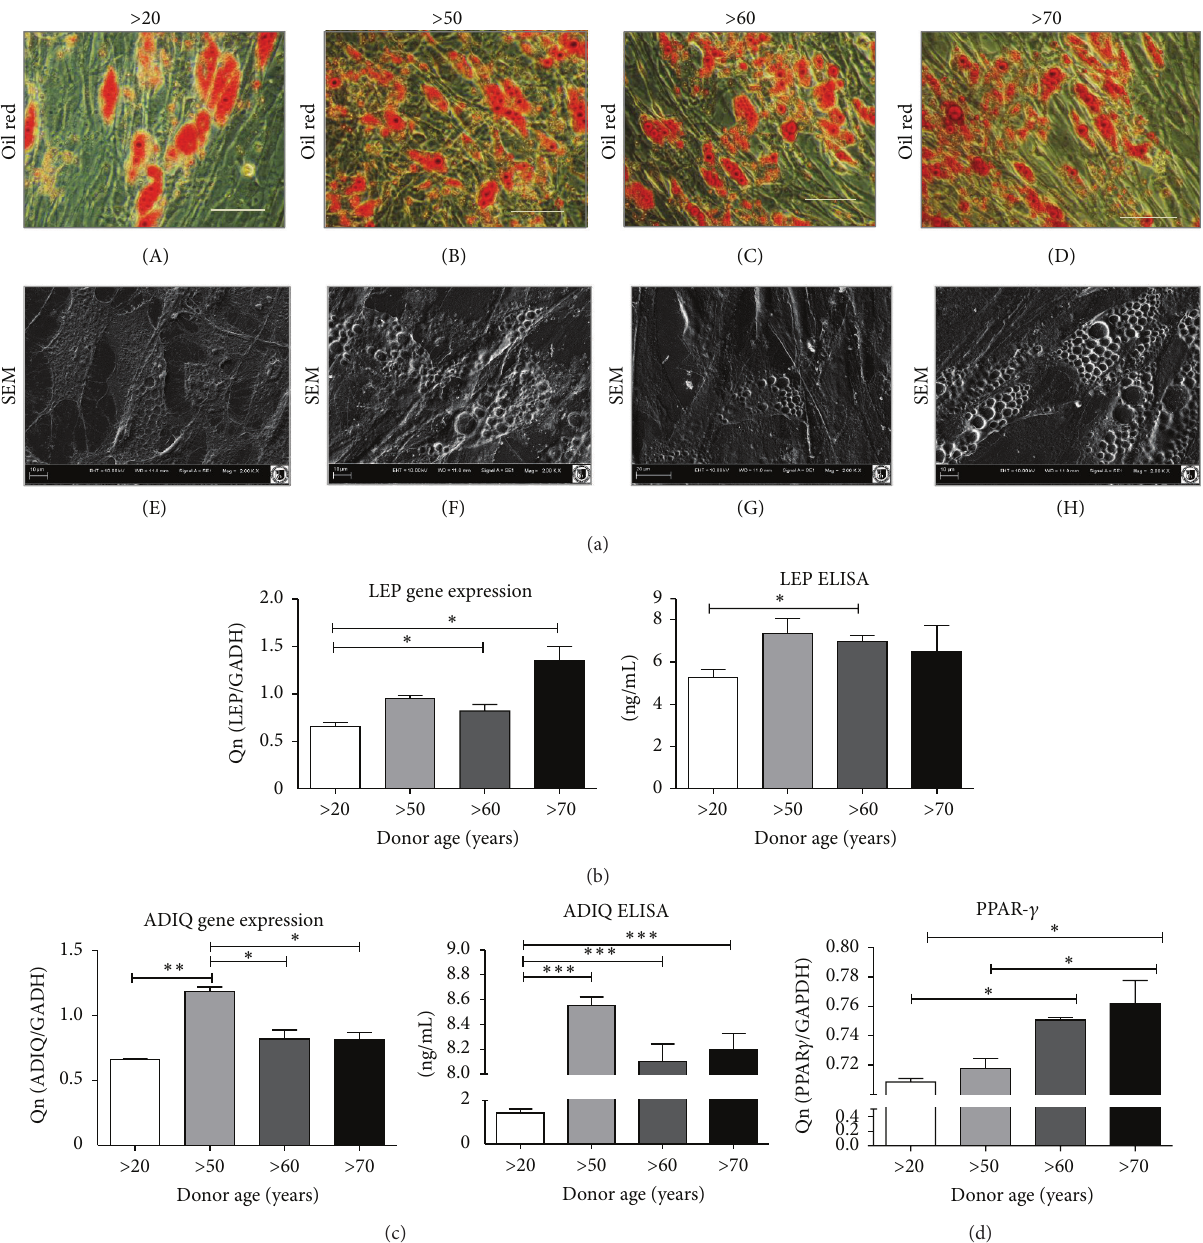
Figure 9: Characterization of age related changes in hASCs adipogenic differentiation potential. (a) Morphology of cells cultured in adipogenic medium visualized by Oil Red O staining (A–D) and SEM (E–H). Quantitative ELISA analysis and gene expression of LEP (b) and ADIQ (c). Gene expresion analysis of PPAR- 𝛾 (d). Results expressed as mean ± SD. ∗ 𝑝 value <